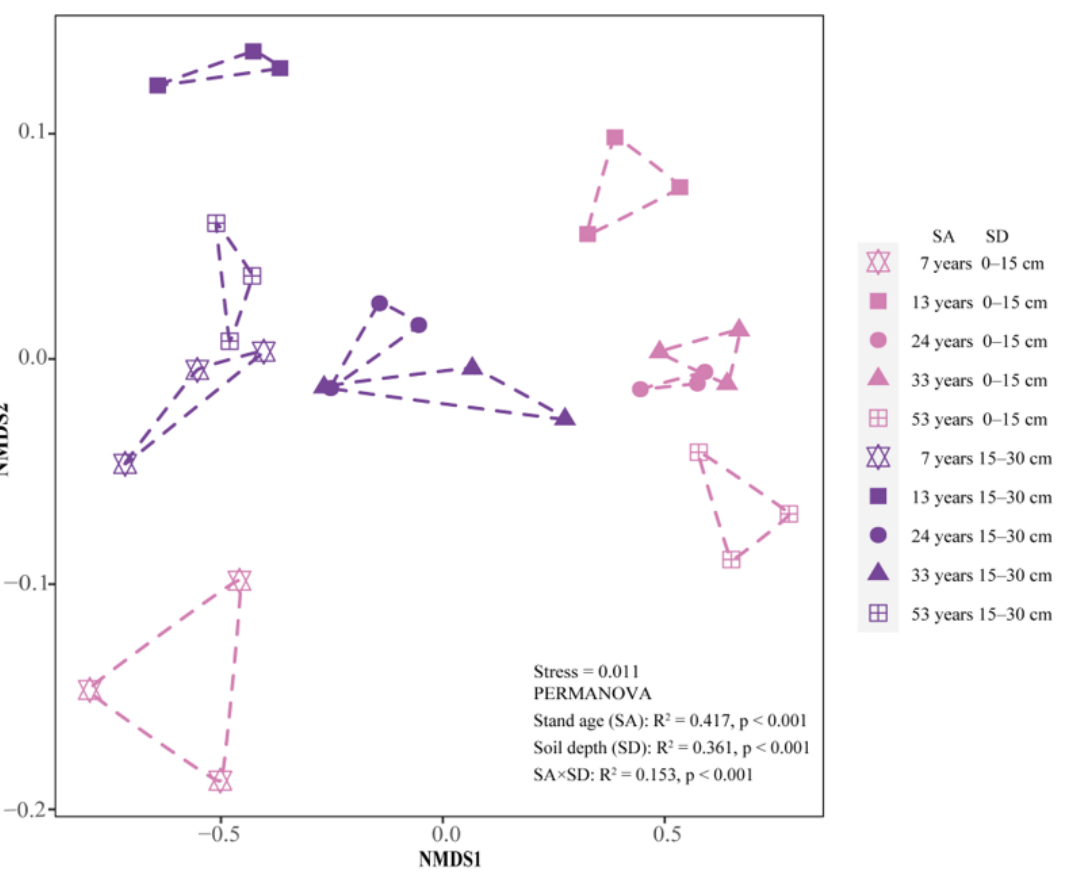
Figure 2. The results of non ‐ metric multidimensional scaling (NMDS) and permutational multivar ‐ iate analysis of variance (PERMANOVA) for all specific biomarker phospholipid fatty acids (PLFAs) are based on the Bray–Curtis distance matrix between different stand ages and soil depths. Colors and point shapes denote the soil depth (SD) and stand age (SA), respectively. The dashed line depicts the grouping of the samples based on the stand age.